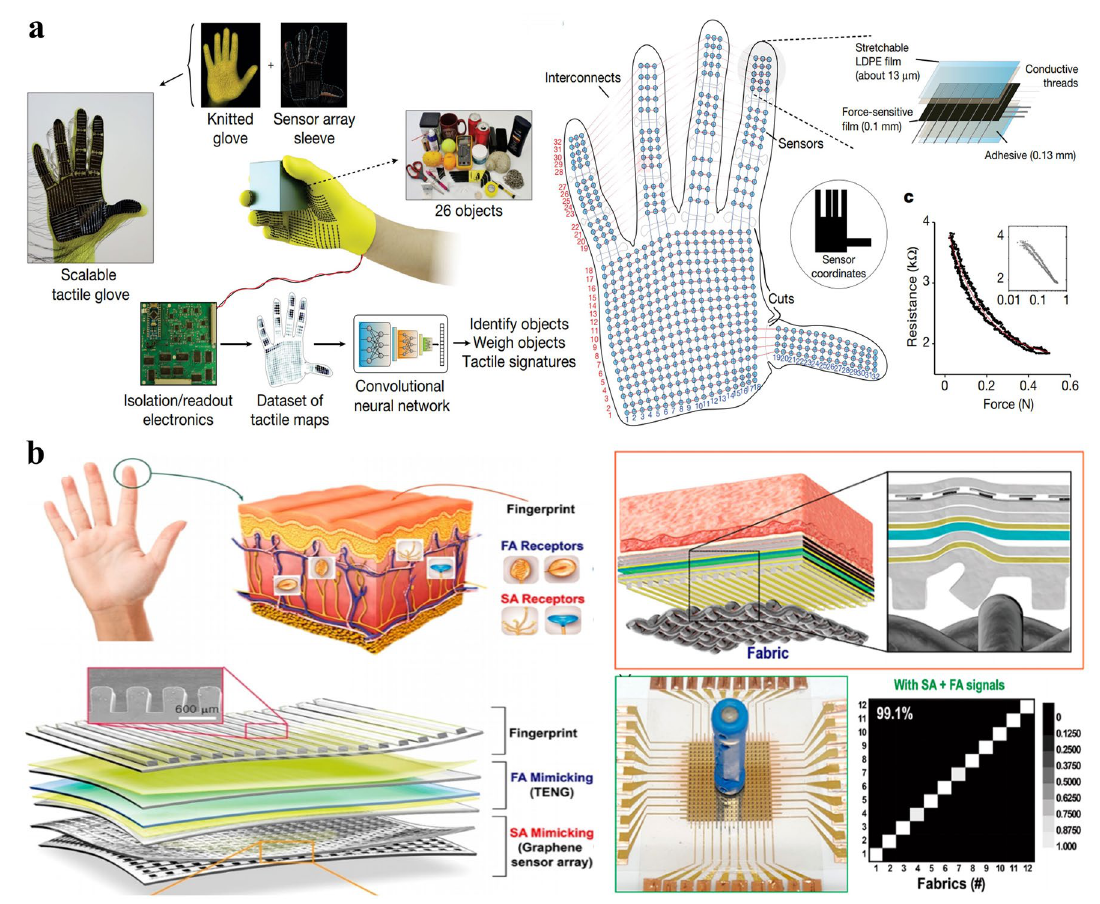
Fig. 12 a Object recognition and weighing enabled by a smart glove and ML techniques [34]. Copyright (2019) Springer Nature. b Texture rec- ognition realized by SA- and FA-mimicking sensors and ML techniques [181]. Copyright (2019) American Chemical